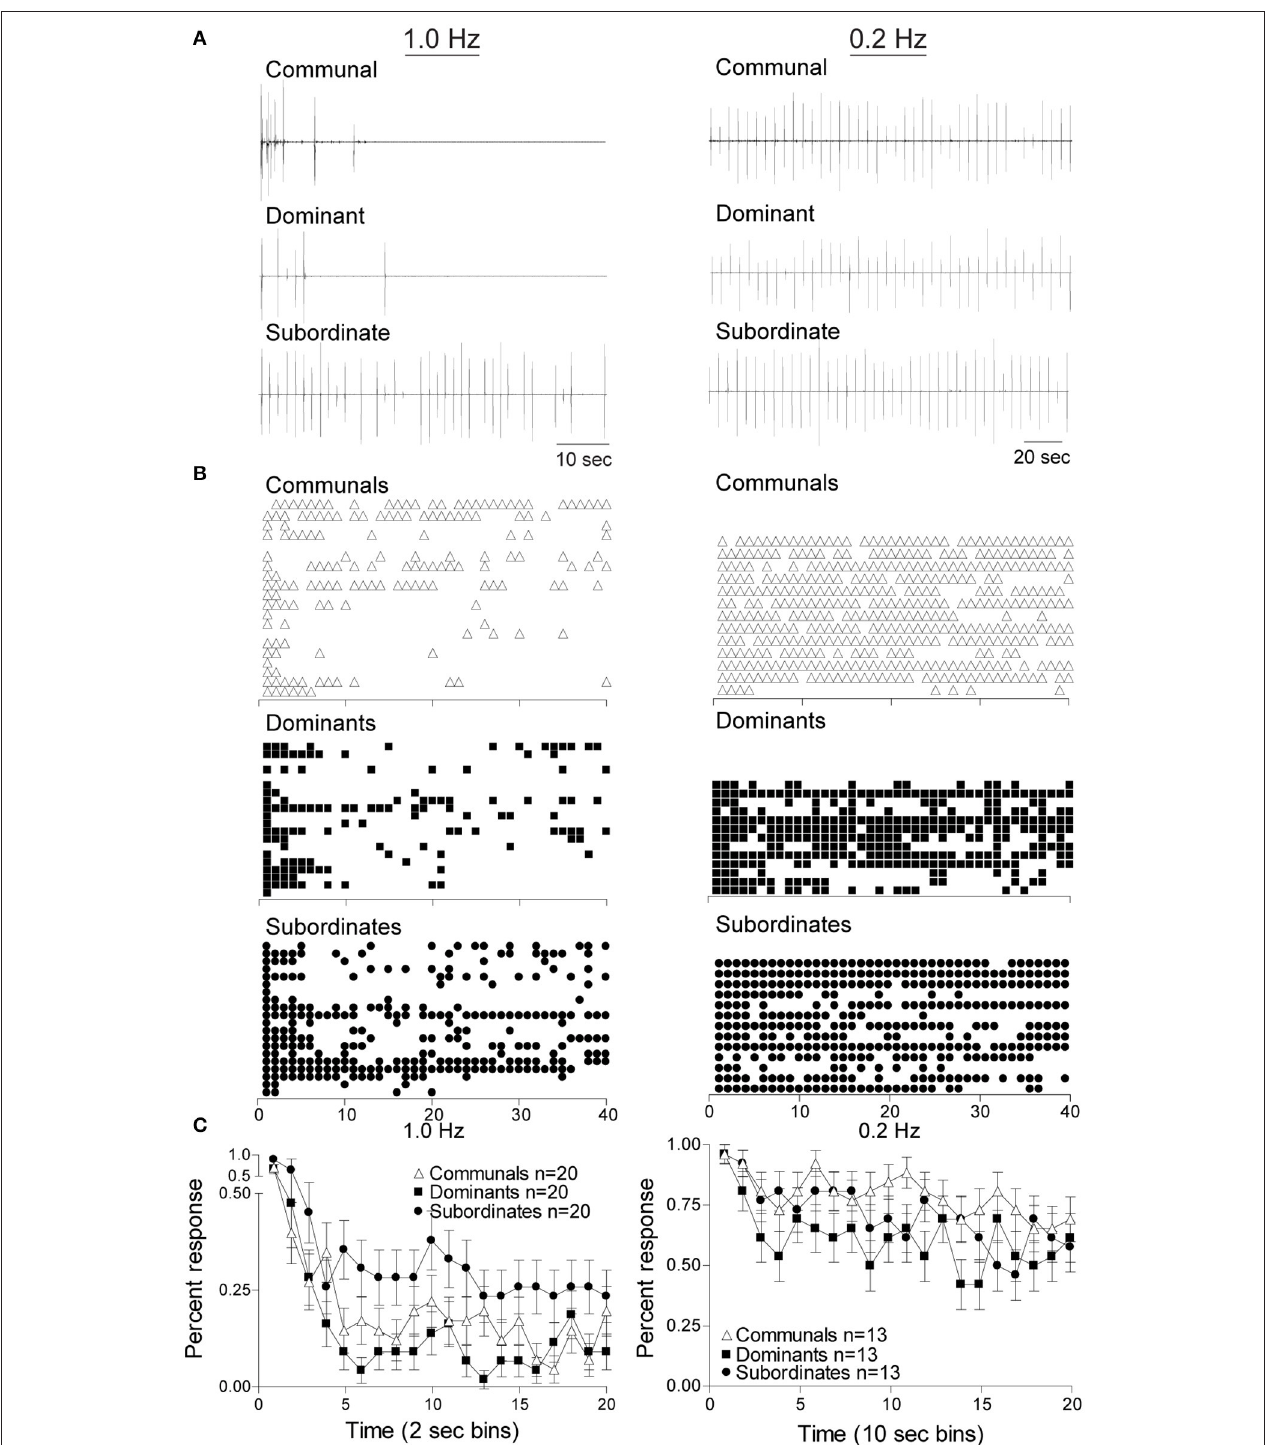
FIGURE 2 | Social status affects the response rates of startle escape. Repeated auditory stimuli at 1Hz (left panel) causes rapid habituation in all animal groups particularly in dominant animals. However, stimuli at 0.2Hz (right panel) leads to modest habituation in all animals groups. (A) Individual example of response pattern of a communal animal and one pair of dominant and subordinate animals to repeated stimuli at 1Hz (left panel) and 0.2Hz (right panel). Deflections are M-cell mediated field potentials. (B) Raster plots of all animals tested. Each row represents the responses of one animal, and each symbol represents one M-cell mediated escape response. (C) Cumulative percent response patterns binned over 2s periods (left panel) at 1Hz and 10s period (right panel) at 0.2Hz for each group. Mean ± SEM was plotted.